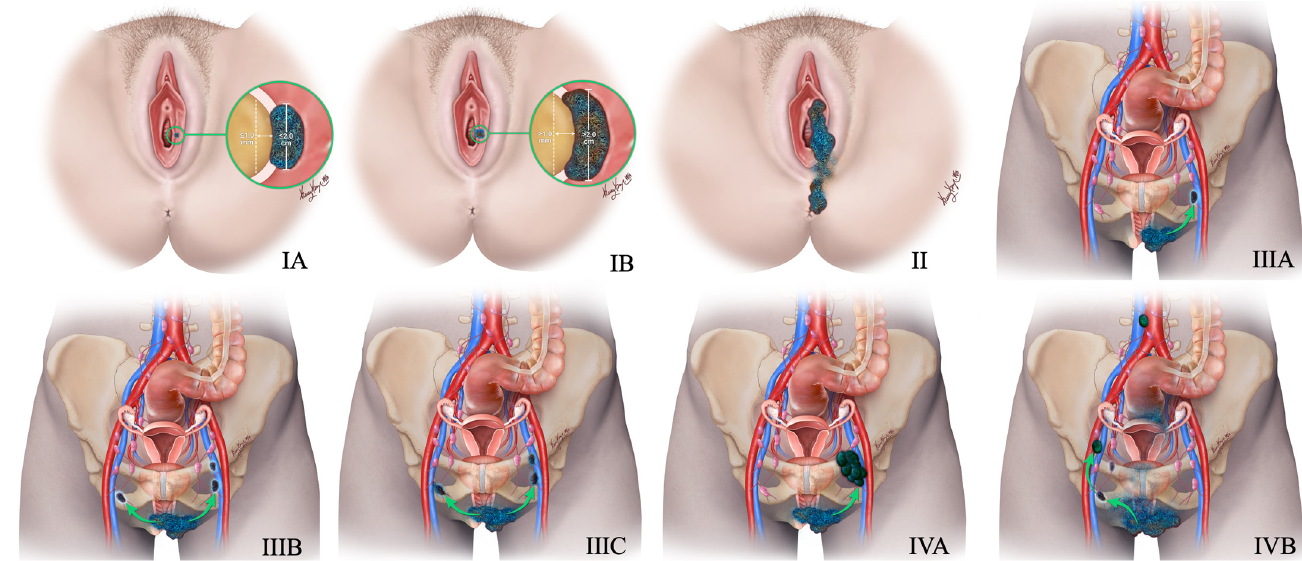
Figure 16. New 2021 FIGO Staging of vulvar tumors. Stage-I tumor confined to the vulva. Stage IA tumor size less than equal to 2 cm and stromal invasion less than equal to 1 mm. Stage IB tumor size more than 2 cm and stromal invasion more than 1 mm. Stage II tumor of any size with extension to lower one-third of the urethra, lower one-third of the vagina, lower one-third of the anus with negative nodes. Stage III tumor of any size with extension to the upper part of adjacent perineal structures or with any number of nonfixed, nonulcerated lymph nodes. Stage IIIA tumor of any size with disease extension to the upper two-thirds of the urethra, upper two-thirds of the vagina, bladder mucosa, rectal mucosa, or regional lymph node metastases less than equal to 5 mm. Stage IIIB regional lymph node metastases more than 5 mm. Stage IIIC regional lymph node metastases with extracapsular spread. Stage IV tumor of any size fixed to bone or fixed, ulcerated lymph node metastases, or distant metastases. Stage IVA disease fixed to the pelvic bone or fixed or ulcerated regional lymph node metastases. Stage IVB distant metastases.